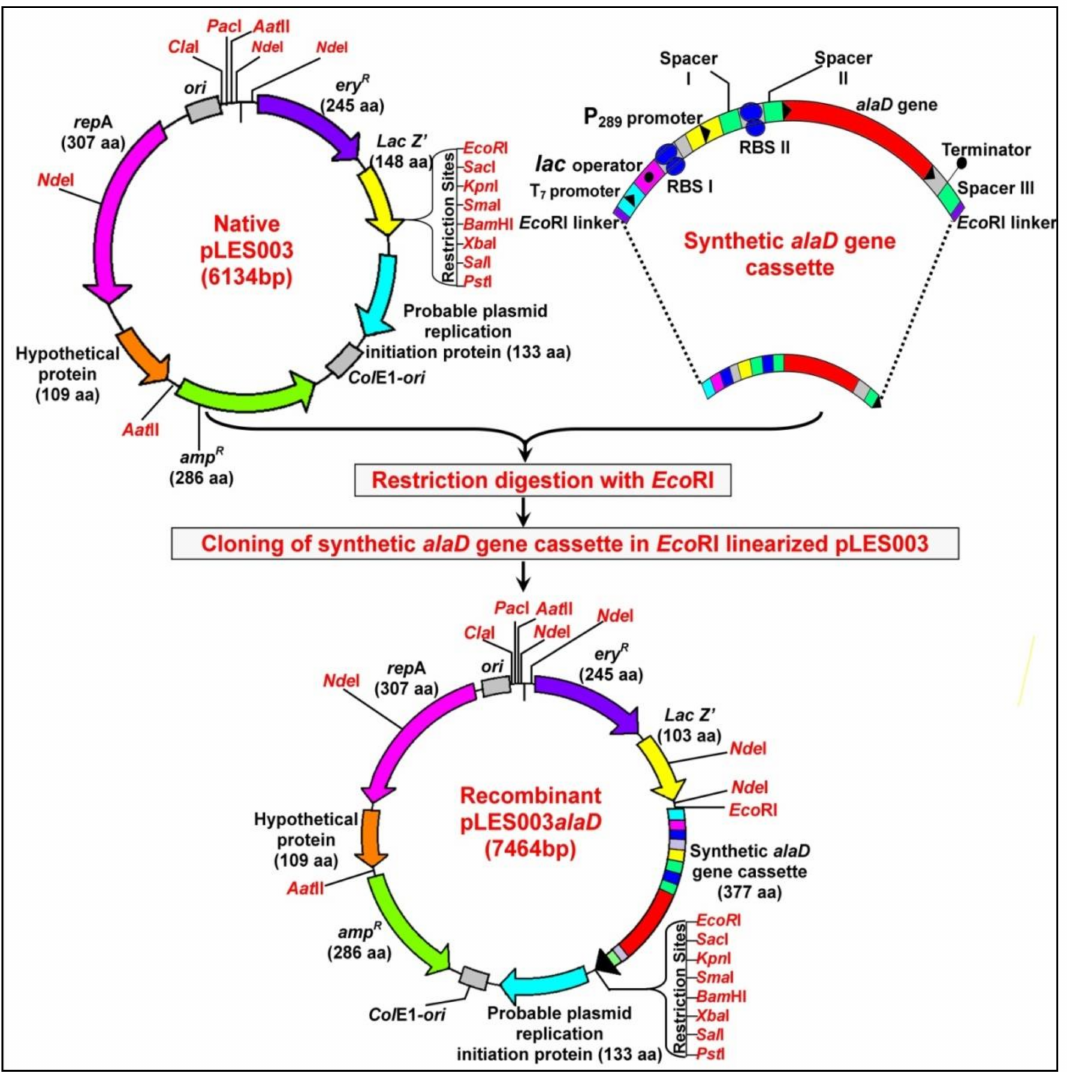
Figure 1. Genetic, restriction and regulatory features of native pLES003 vector (6134bp) and construction of recombinant pLES003 alaD vector (7464 bp) expressing synthetic alaD gene